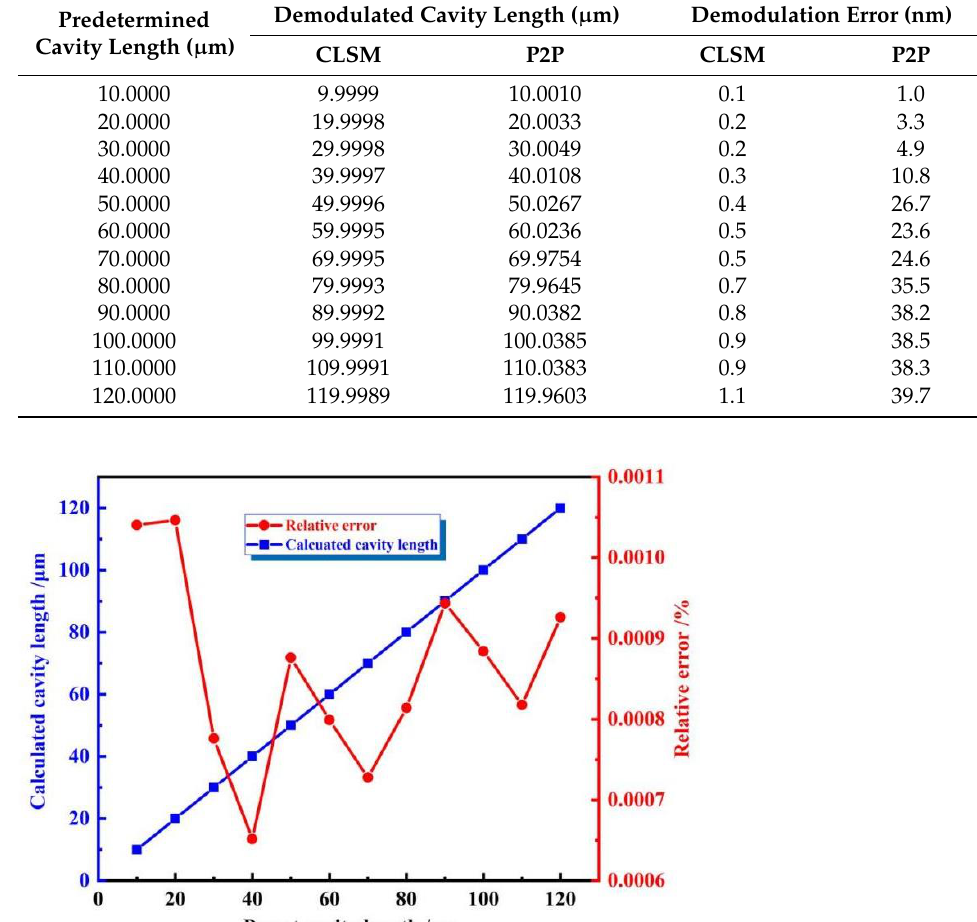
Table 1. Simulated demodulation results for 10–120 µ m FP cavities through the CLSM and double- peak algorithm.